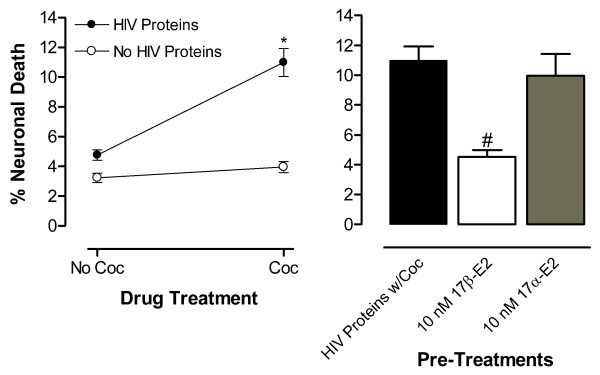
17β-, not 17α-E2, protects human fetal neurons against the synergistically toxic of incubation with Tat [40 nM] plus gp120 [32.5 pM] (HIV Proteins) plus cocaine (Coc) [1.6 μM]. Control conditions of incubation with Locke's Buffer vehicle or the HIV proteins or Coc only produced similar neuronal death. (Left Panel) Significant interaction of the HIV proteins with Coc, as illustrated by the lines diverging from parallel, produced toxic synergism (*p < 0.0008). (Right Panel) Significant neuroprotection by 17β-E2 against HIV proteins w/ Coc toxic synergism (#p < 0.0001).